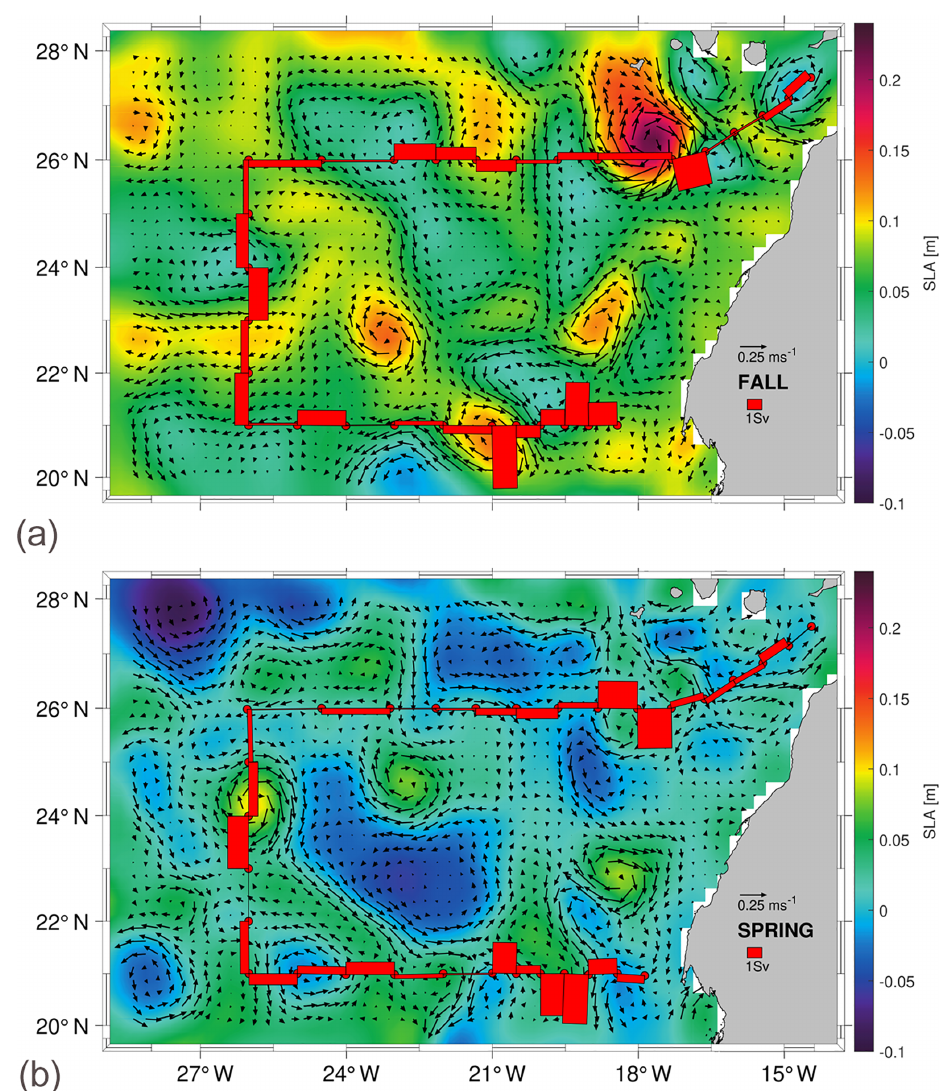
Figure 11. Average derived geostrophic velocity and SLA during fall (a) in the course of the fist cruise and spring (b) in the course of the second cruise, extracted from AVISO + . The red bars represent the mass transports in the shallowest layer as estimated by the inverse